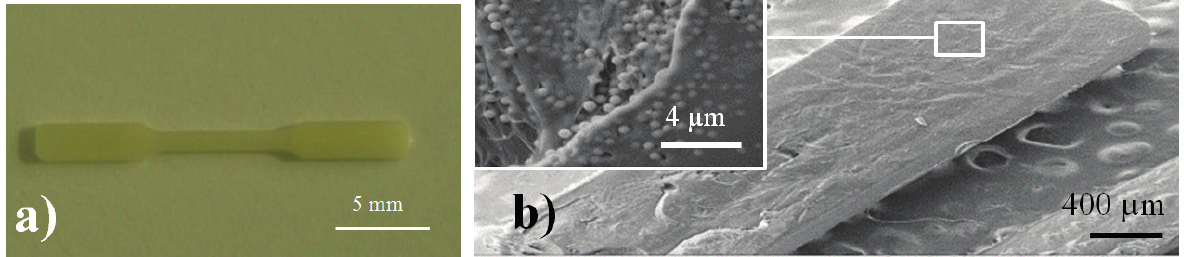
Figure 7. Image of a processed PE99 specimen ( a ); SEM micrograph of details of